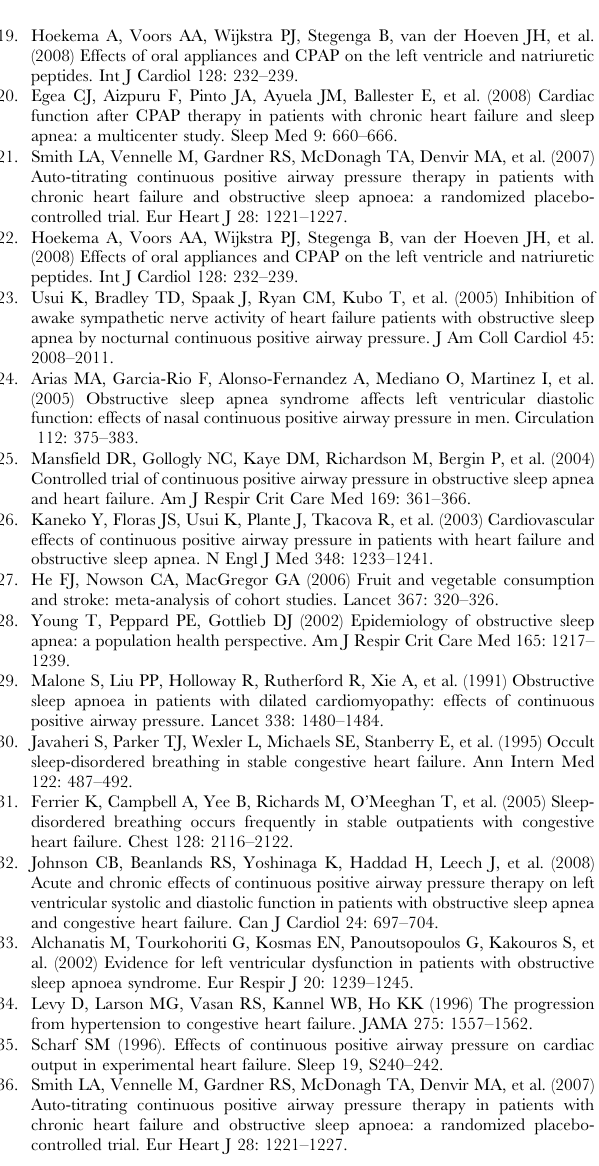
Figure S1 Flow diagram of the literature search. Figure S2 Forest plot presenting the meta-analysis for the effect of CPAP treatment on LVEF. WMD: weighted mean difference; CI: confidence intervals. Figure S3 Forest plot presenting the meta-analysis for the effect of CPAP treatment on LVEF except Hoekema’s study. WMD: weighted mean difference; CI: confidence inter- vals.